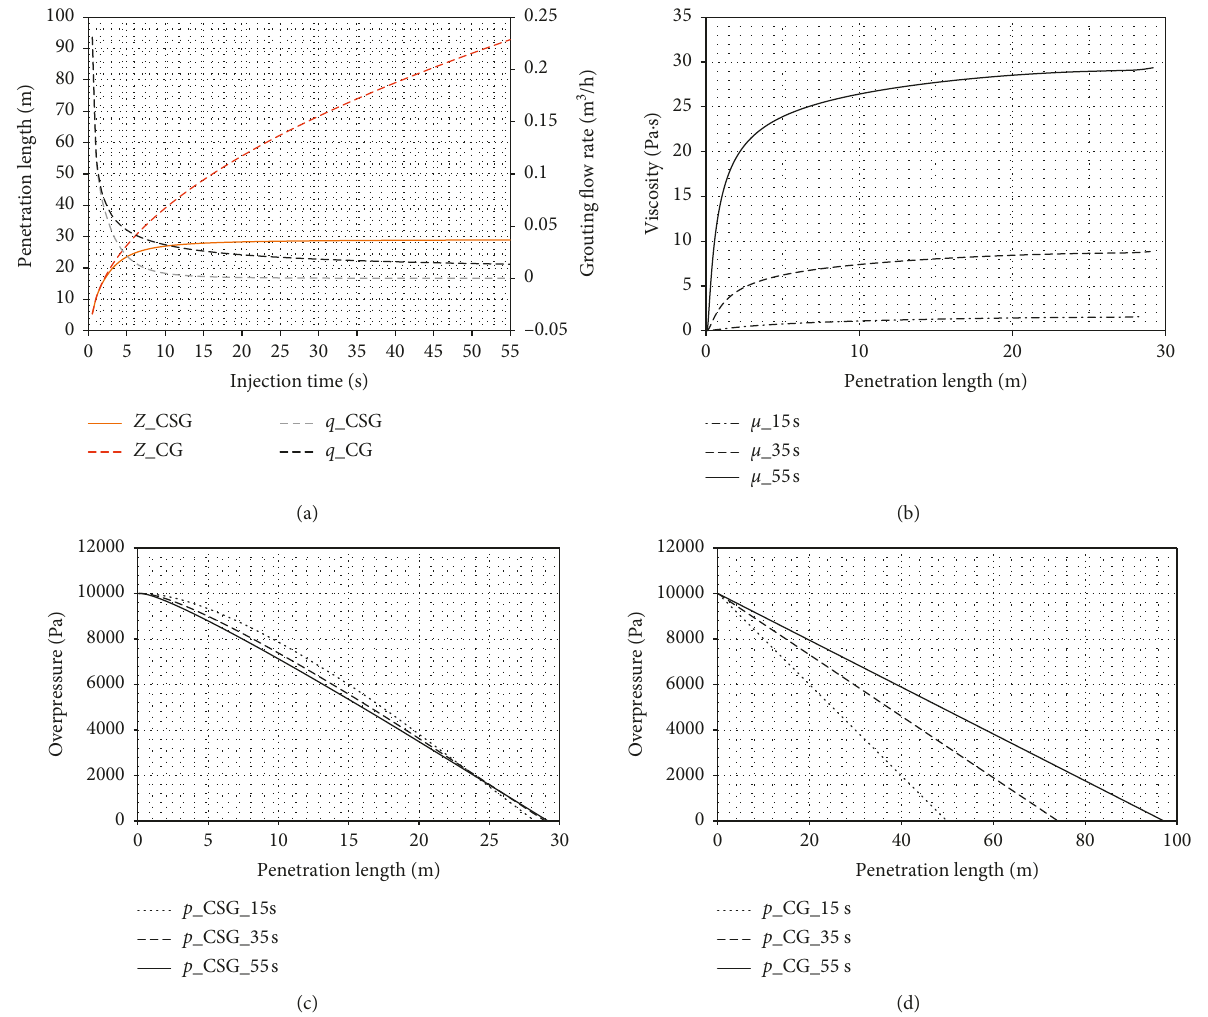
Figure 7: The calculation results for the pressure control injection mode. (a) Variation in penetration length and grouting flow rate with injection time. (b) Viscosity distribution along penetration length. (c) Overpressure distribution in grouted zone for the CSG at three grouting times, 15, 35, and 55s. (d) Overpressure distribution in grouted zone for the CG at three grouting times, 15, 35, and